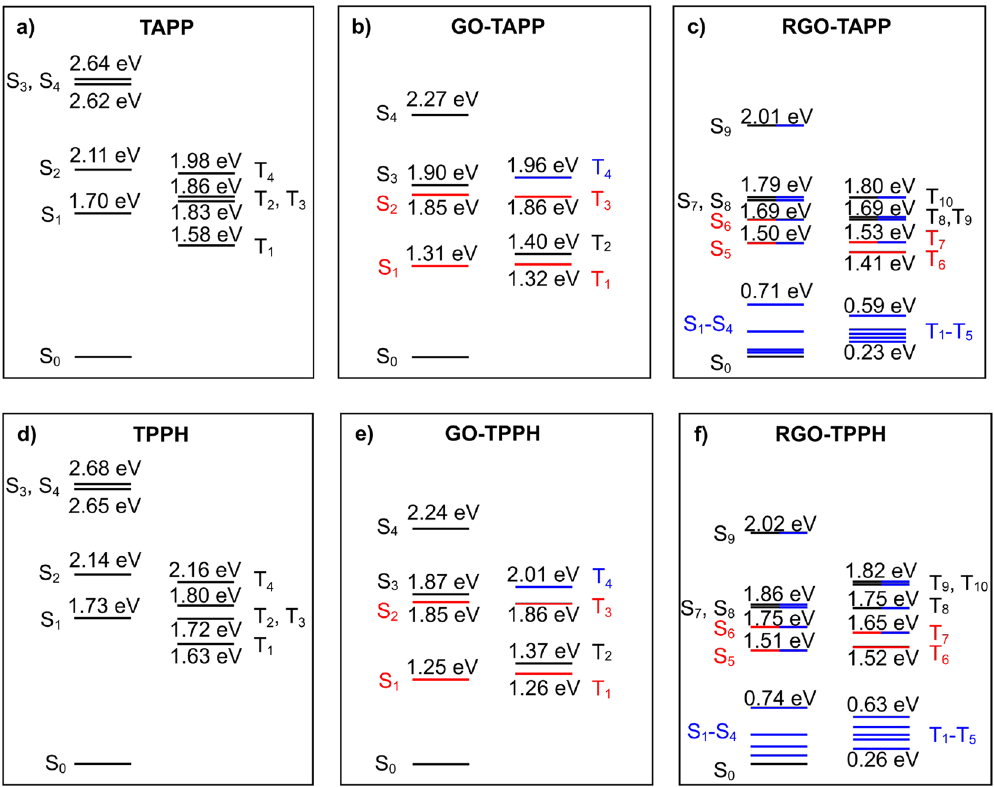
Figure 8. State-energy diagram for TAPP ( a ) and its nanohybrids with GO ( b ) and RGO ( c ) as well as analogous diagrams for TPPH species ( d – f ). State energies were computed at the DLPNO-NEVPT2 level. Excited states are classified as TAPP/TPPH-centered, GO/RGO-centered and charge-transfer and are marked in black, blue and red, respectively. Mixed states are denoted with two colors corresponding to dominant